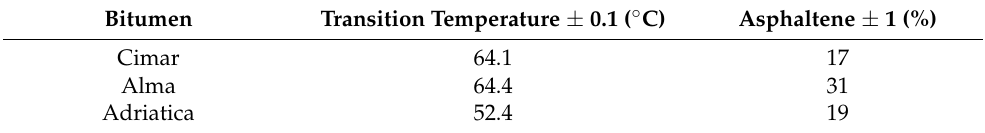
Table 3. Transition temperature and percentage asphaltene of all bitumen